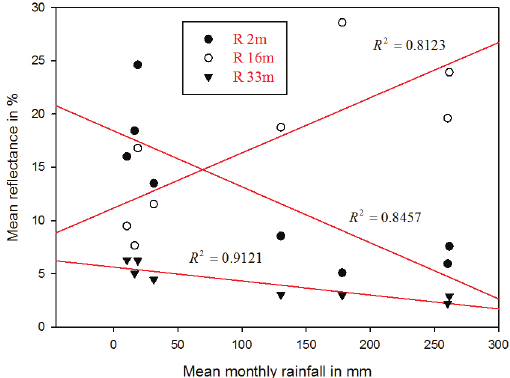
Figure 5 - Spearman non-parametric correlation and robust regression lines between mean monthly rainfall and mean monthly reflectance of PAR above the canopy (33 m) and below the canopy (2 m and 16 m).